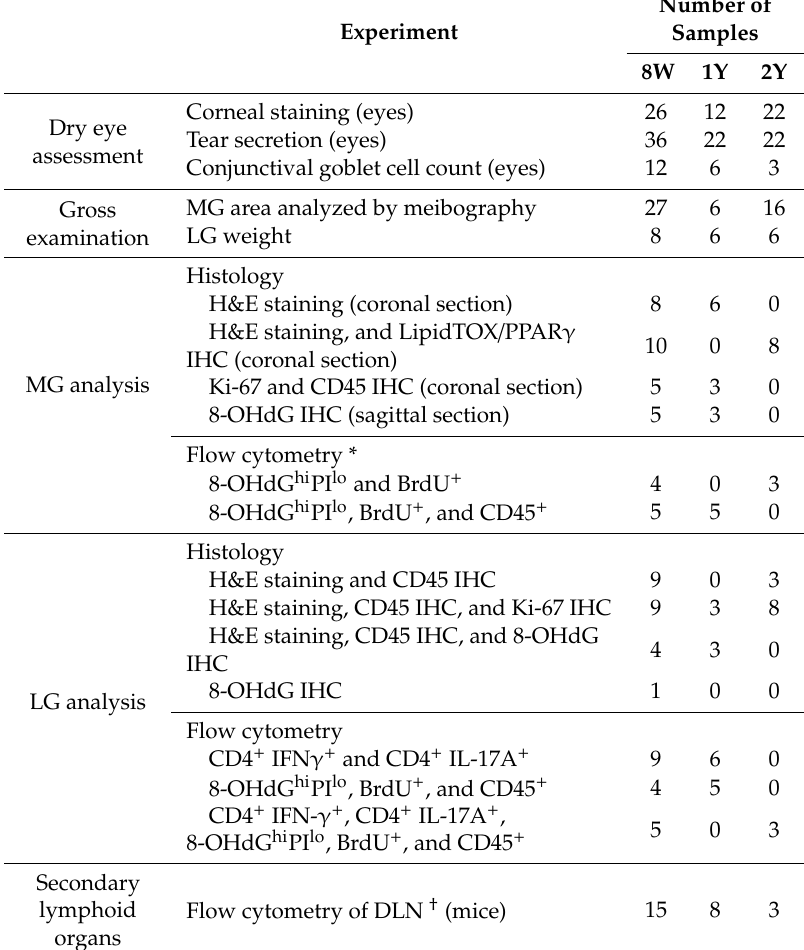
* Upper and lower samples of each eye were pooled and analyzed. † Bilateral cervical lymph nodes were pooled for analysis. Abbreviations: W, week-old; Y, year-old; MG, meibomian gland; LG, lacrimal gland; H&E,